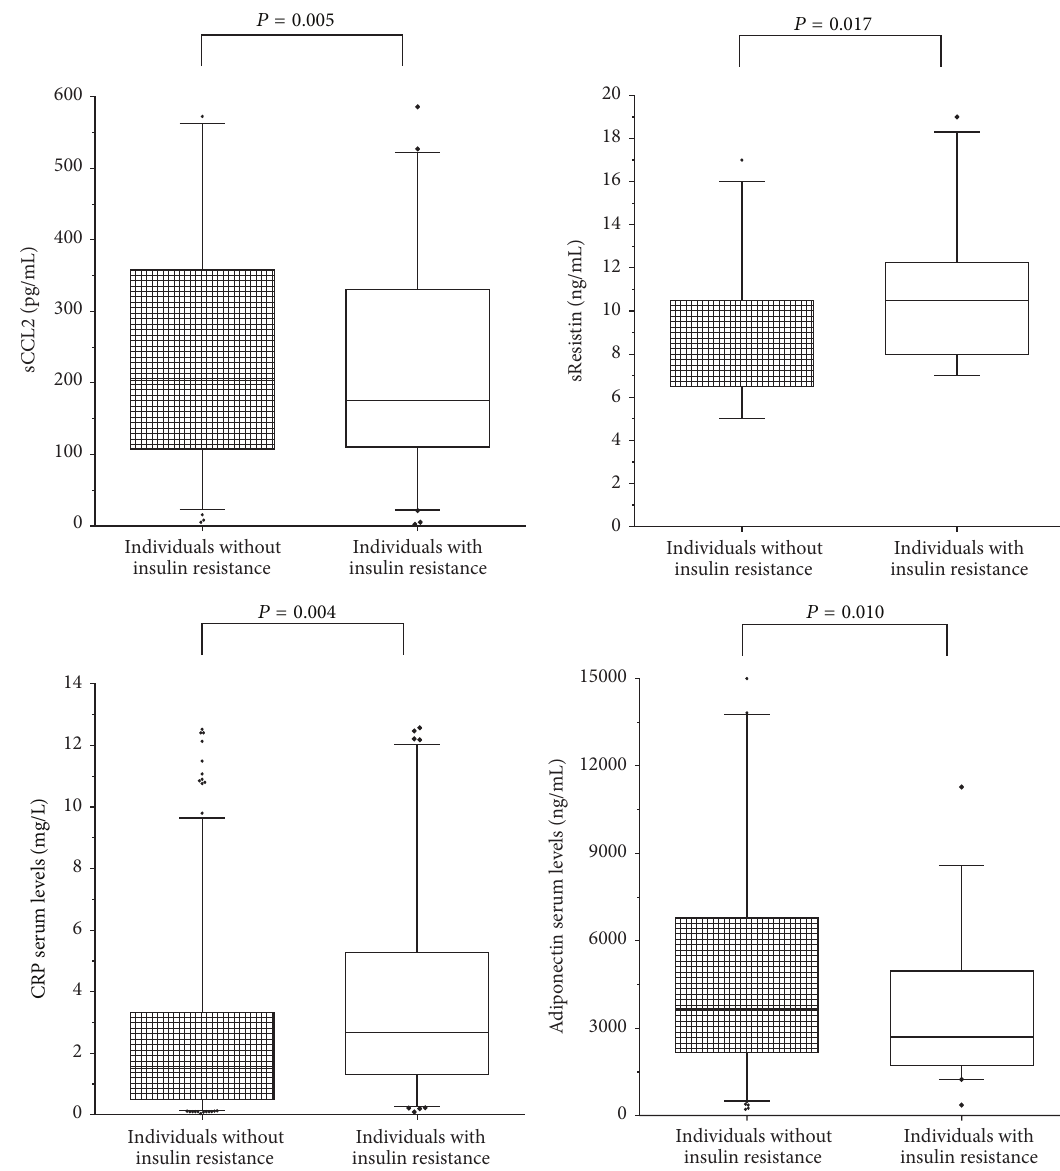
Figure 1: Soluble levels of adipokines and CRP by study group. 𝑛 = 380 . Student’s 𝑡 -test with 𝑃 significantly, comparing the groups: individuals with IR versus individuals without